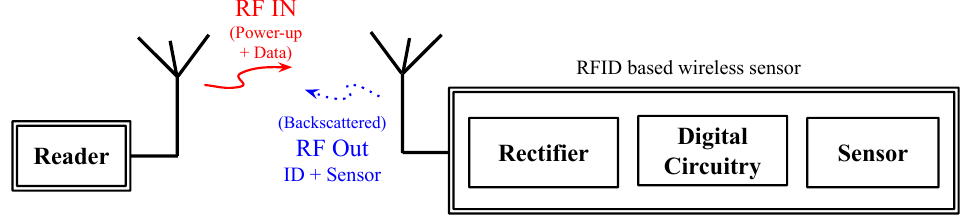
Figure 3. Components of an RFID-based wireless sensor